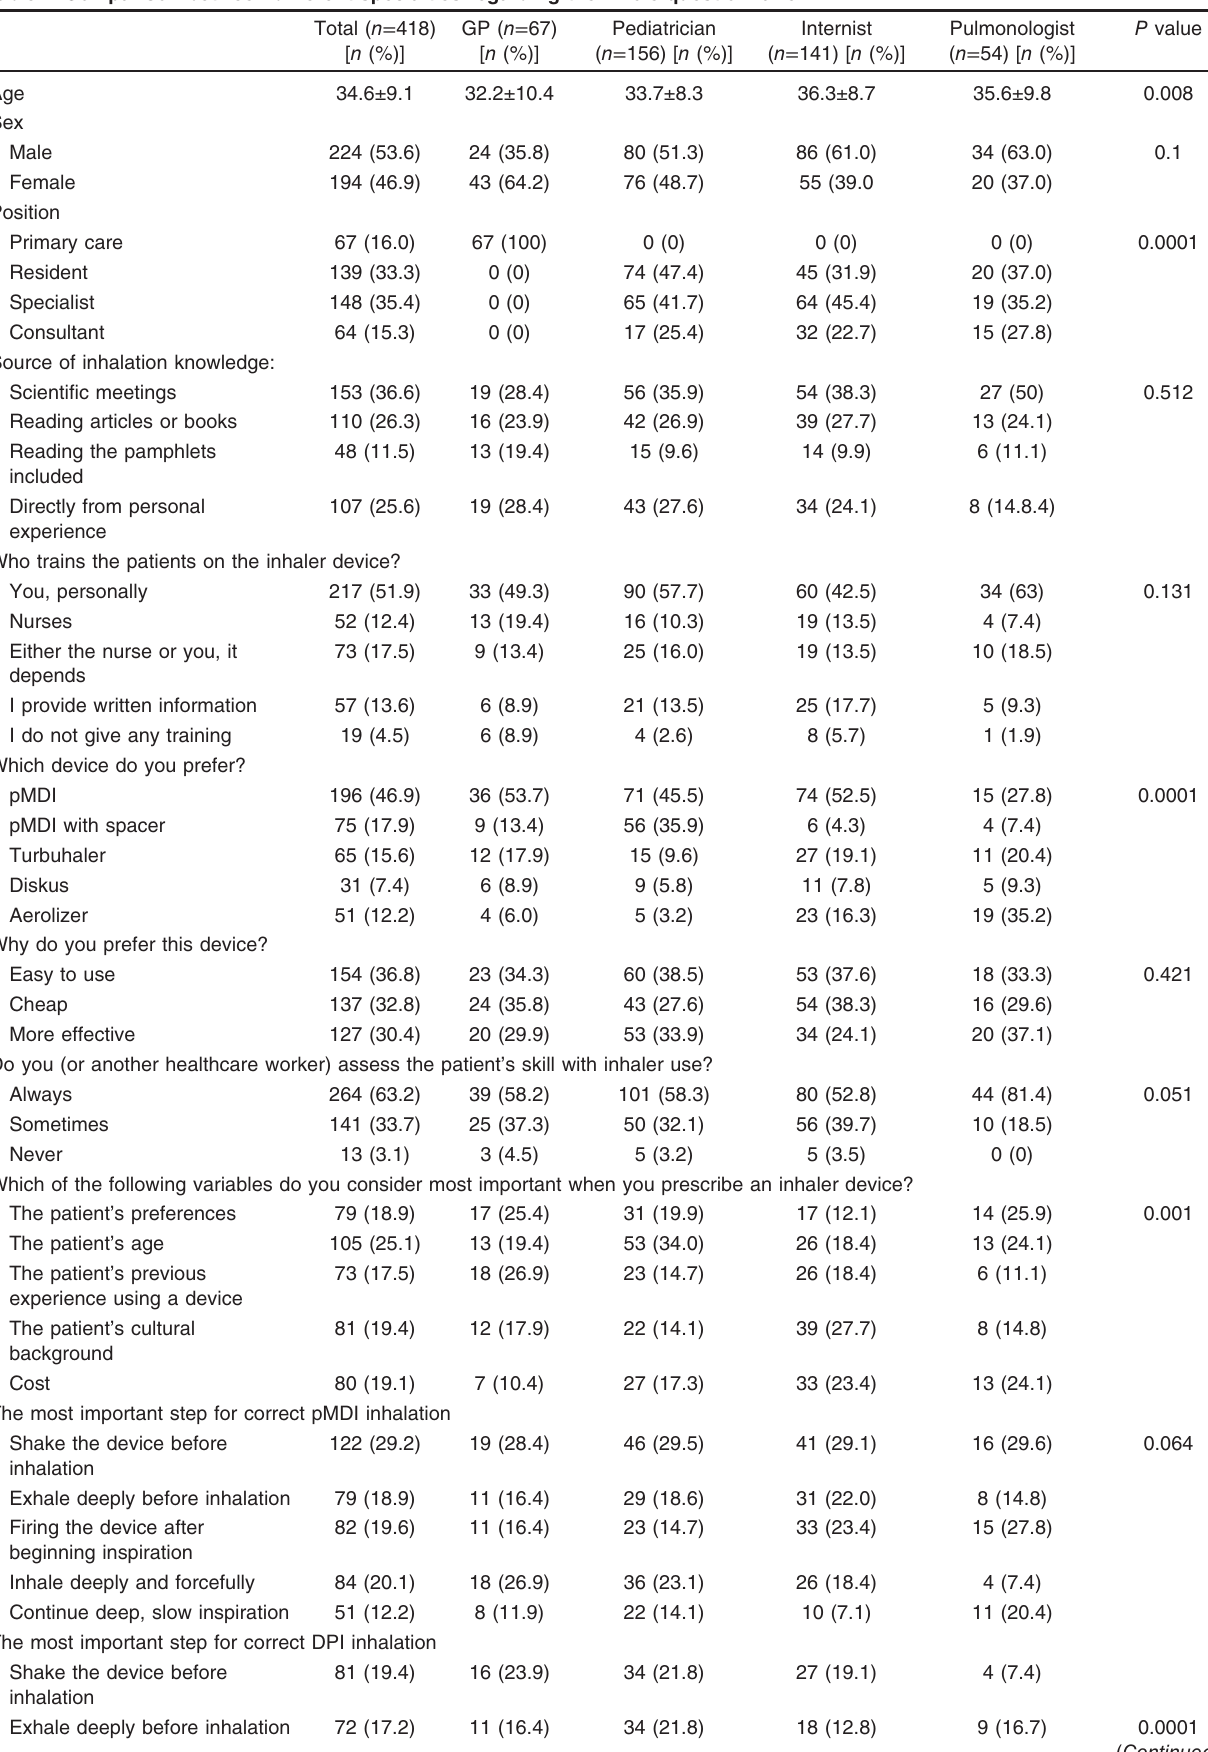
Table 1 Comparison between different specialties regarding the whole